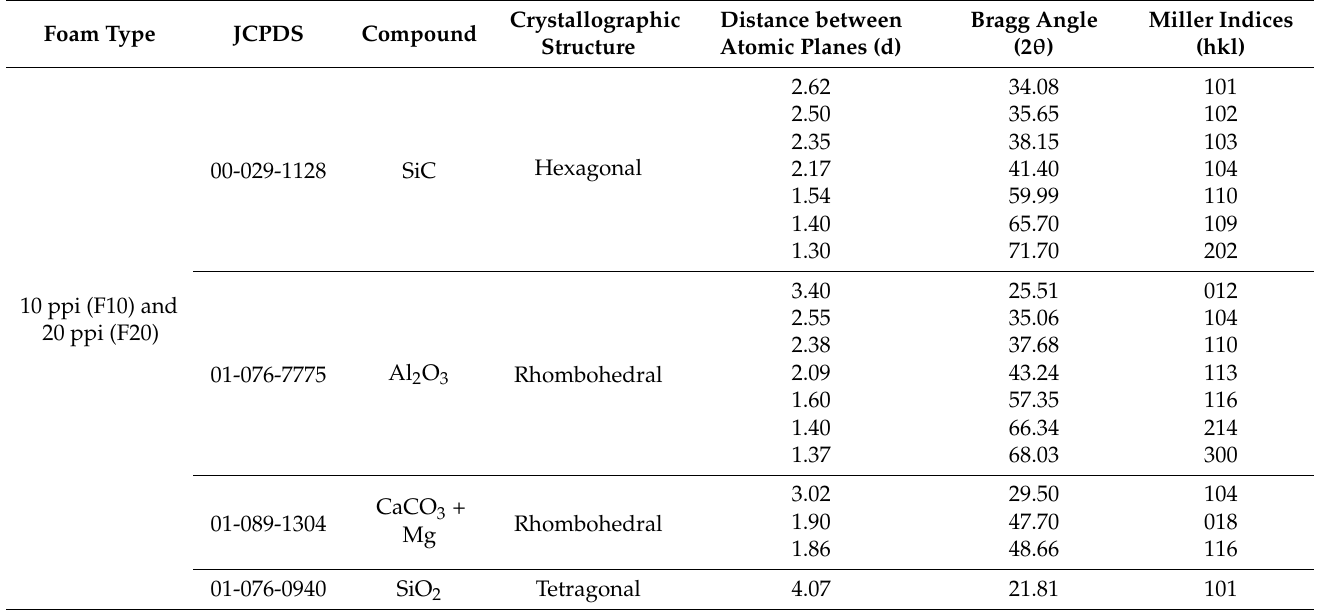
Table 2. SiC foam compounds identified by X-ray